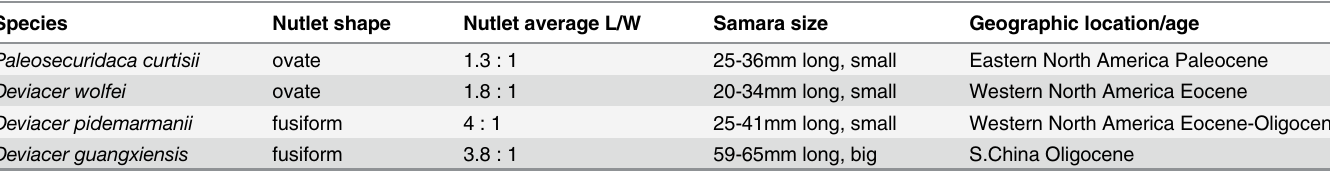
Table 1. Comparison among similar